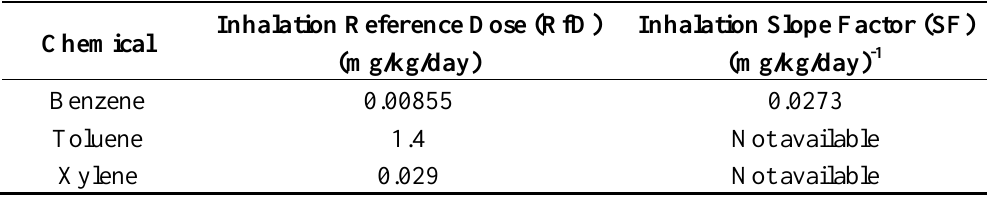
Table 4. Slope Factor for benzene [23]; Reference Dose for benzene, toluene and xylene *